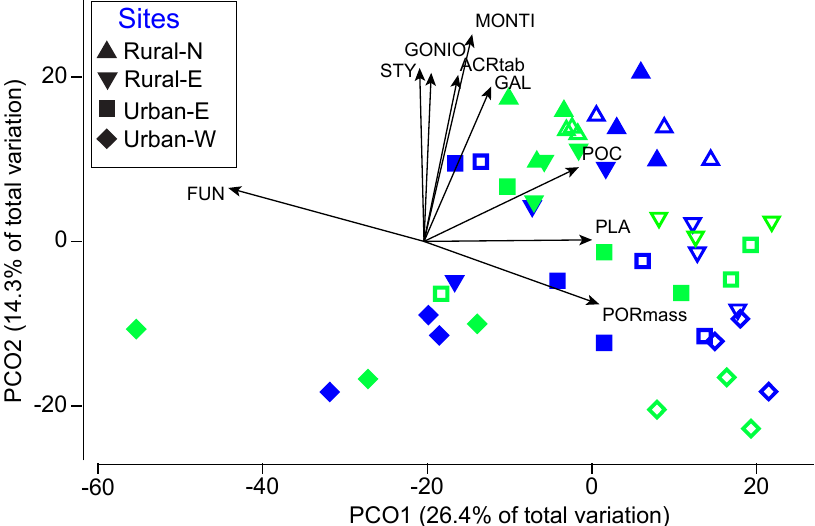
Figure 4. Principal Coordinates Analysis biplot of square root transformed Bray–Curtis similarity ma- trix of the hard coral genera counted on belt transects. Empty and solid markers indicating 5 and 10 m depths, respectively. Color indicates survey year: blue-2015 and green-2017. Vectors represent top nine coral genera/morphology correlated to axes as calculated by Person’s correlation.